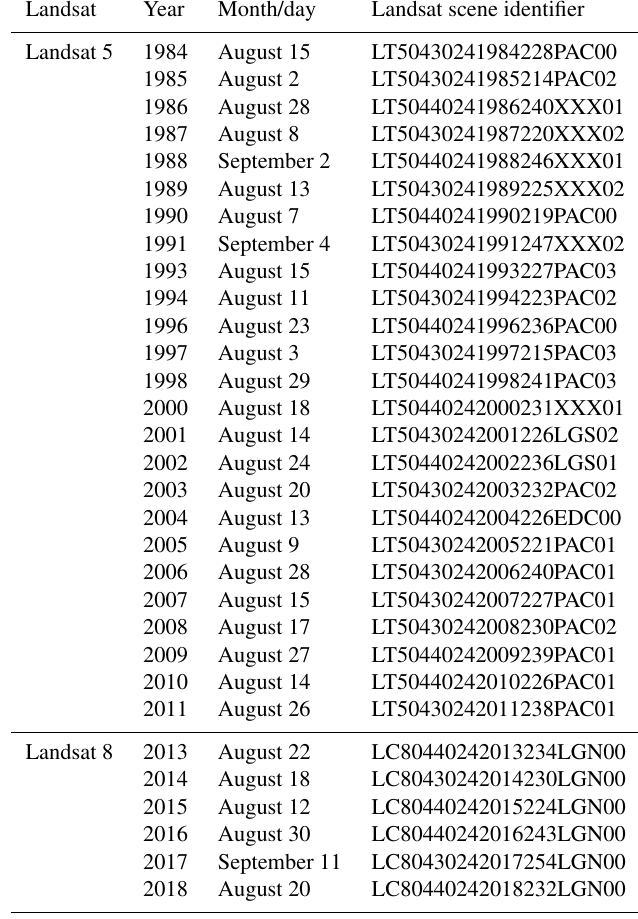
Table 10. Landsat images for generating land-cover maps of the